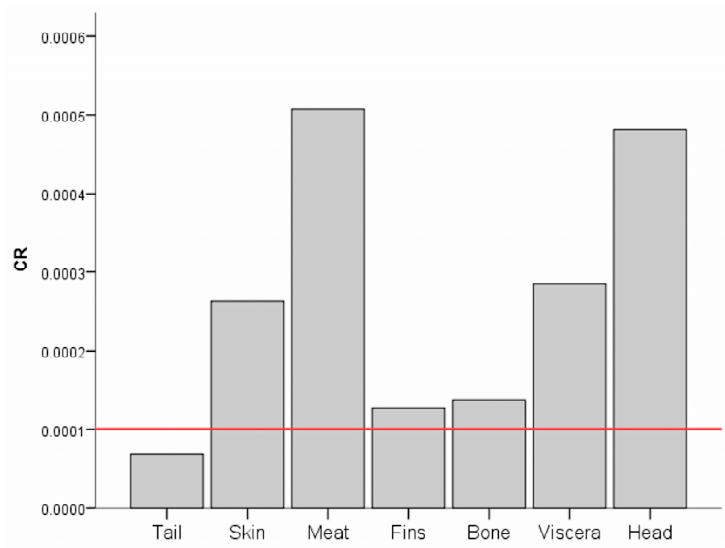
Figure 5. CR of HMs in various parts of Tilapia spp.